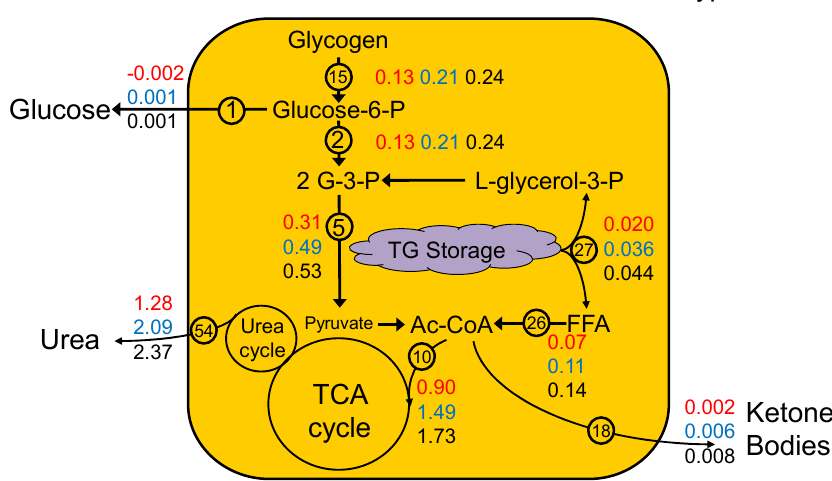
Figure 4. Summary of major fluxes during defatting of steatotic HepG2s. Values shown are representative fluxes (reaction number is shown) for each major pathway from Table 2 estimated by MFA during defatting under normoxic conditions with basal medium (DMEM), medium supplemented with defatting agents, and under hyperoxic conditions with medium supplemented with defatting agents.